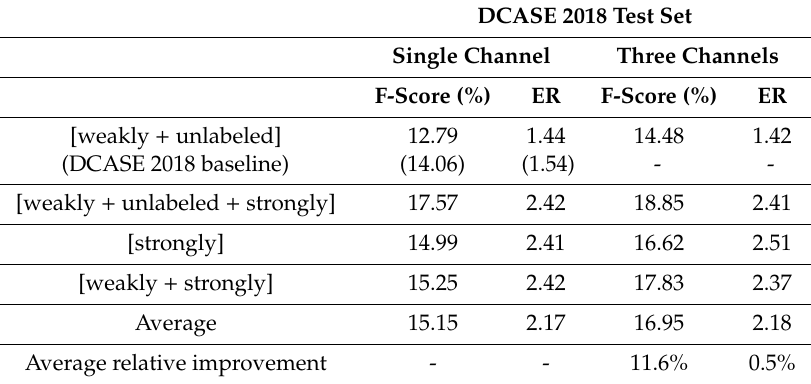
Table 3. Sound event detection (SED) results for the basic CRNN using derivative features (DCASE 2018 test